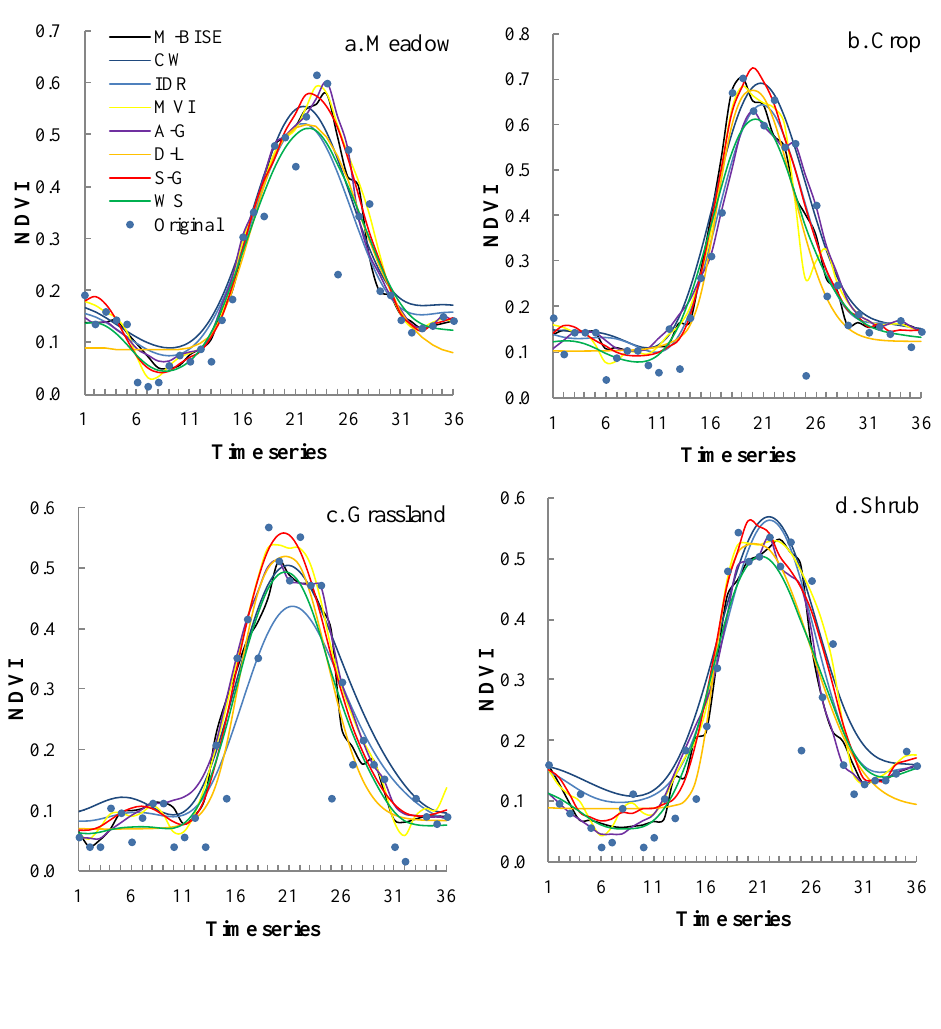
3. Eight techniques fitted to PAL NDVI time-series data acquired from homogeneous pixels of ( a ) meadow; ( b ) crop; ( c ) grassland; ( d ) shrub; and ( e ) desert